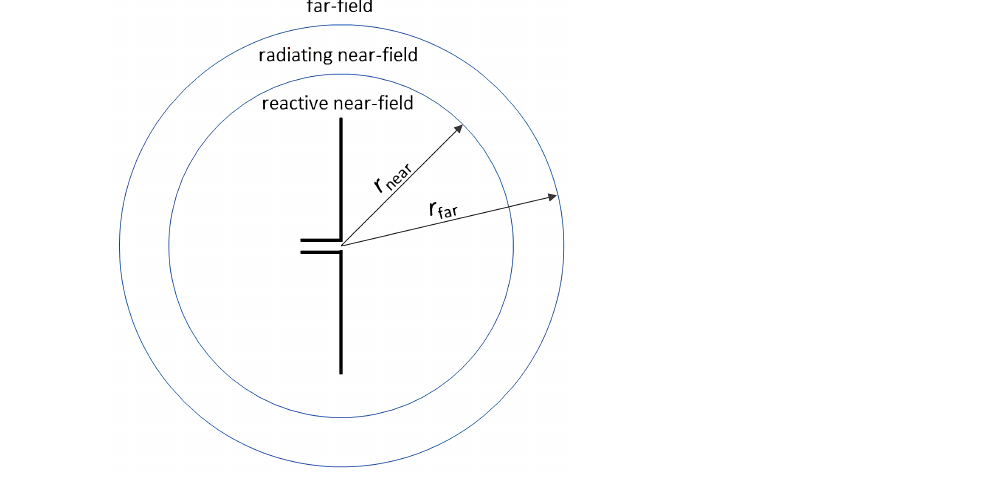
Figure 1. Schematic view of an antenna and the surrounding field regions, described by the radii r far and r near .